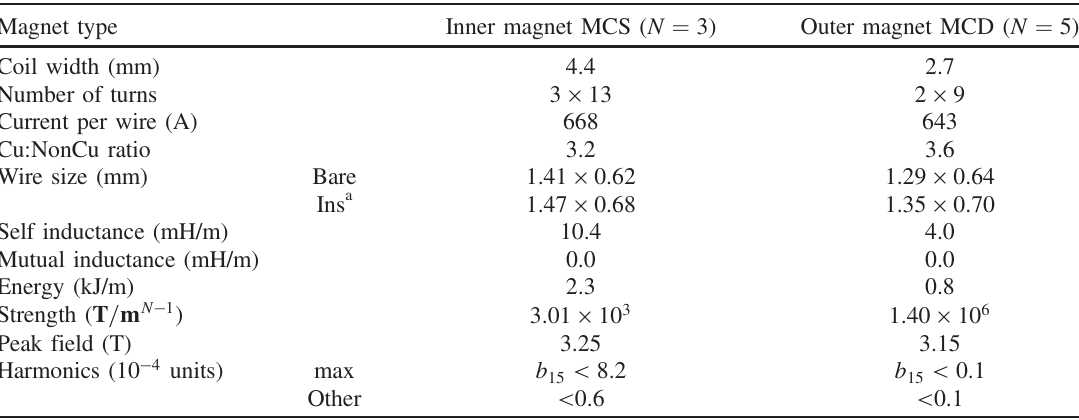
TABLE III. Optimal magnet parameters for nested MCS/MCD configuration with respect to required strengths. The number of turns and wire size are expressed as “ radial × azimuthal ” . Harmonics are expressed at reference radius r 0 ¼ 17